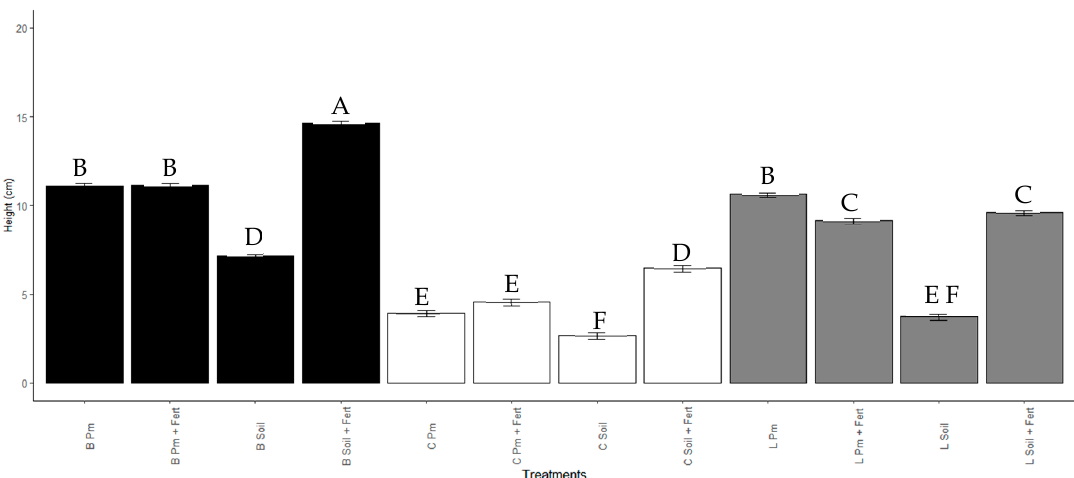
Figure 6. Height of Habanero pepper seedlings with or without inoculation with Enterobacter sp. ITCB-09 after 60 days of cultivation. The different letters on the bars indicate significant differences ( p < 0.001) based on Bonferroni comparisons; whiskers represent the standard errors. Black bars indicate the treatments with pearls ( Enterobacter sp. ITCB-09); white bars indicate the controls; gray bars indicate the treatments with liquid ( Enterobacter sp. ITCB-09).